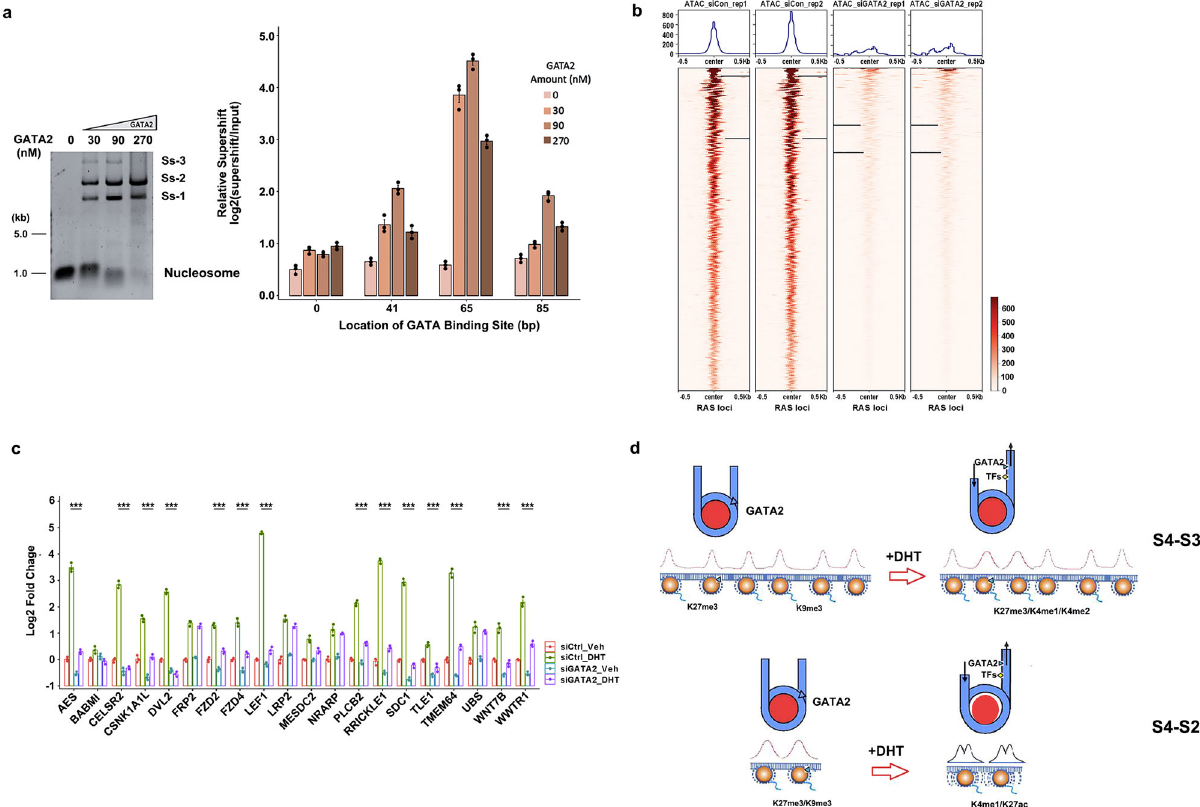
Fig. 6 Performing functional examinations on GATA2-mediated nucleosome states switching and GATA2-regulated Wnt/ β -catenin signaling genes. a Nucleosomes containing 16 different sequences were bound to increase amounts of GATA2 protein and separated by native PAGE. Nucleosomes with 30, 90, and 270 nM of GATA2 and the major supershift bands (Ss-1, Ss-2, Ss-3) were indicated and quanti fi ed by qPCR relative to the input nucleosomes. Experiments were repeated independently three times with similar results. Each bar represents the mean value with the standard deviation as error bars. b ATAC-seq reads density maps around GATA2-associated RAS loci within 0.5 Kb up/down-stream in siCtrl LNCaP cell line and siGATA2 subline. c RT- qPCR measurement on a set of 20 Wnt/ β -catenin signaling genes in siGATA2 before and after DHT treatment. The center for the error bars represents the mean value and the error bars represent the standard deviation with three experiments with a “ *** ” showing p < 0.001 (two-tailed Student ’ s t -test) between Veh and DHT groups for each gene loci. d A working model showing GATA2 initially binds at the edge of a nucleosome at a crowding array (S4) and recon fi gures it to an accessible primed state (S3/S2) upon androgen (DHT) stimulation, subsequently directly regulates or recruits other TFs to coregulate Wnt/ β -catenin signaling genes. Source data are provided as a Source Data fi